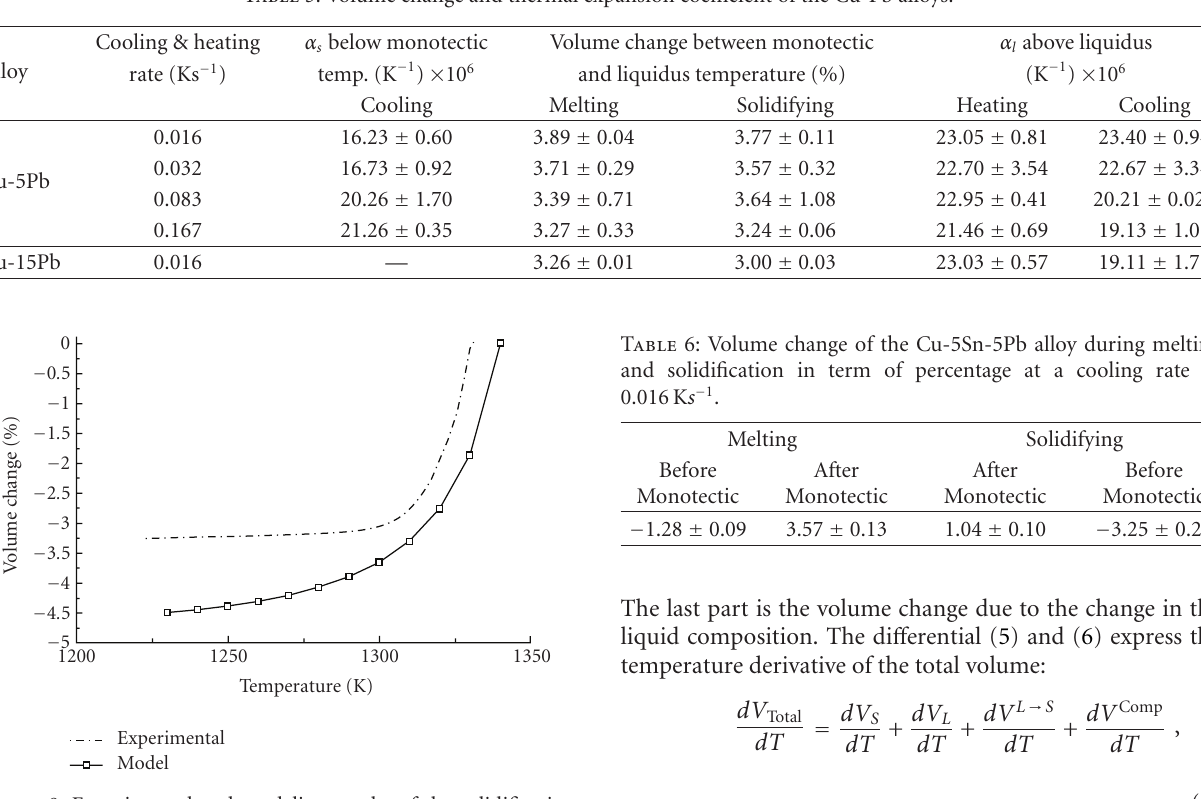
Figure 8: Experimental and modeling results of the solidification shrinkage in the Cu-5Pb alloy.